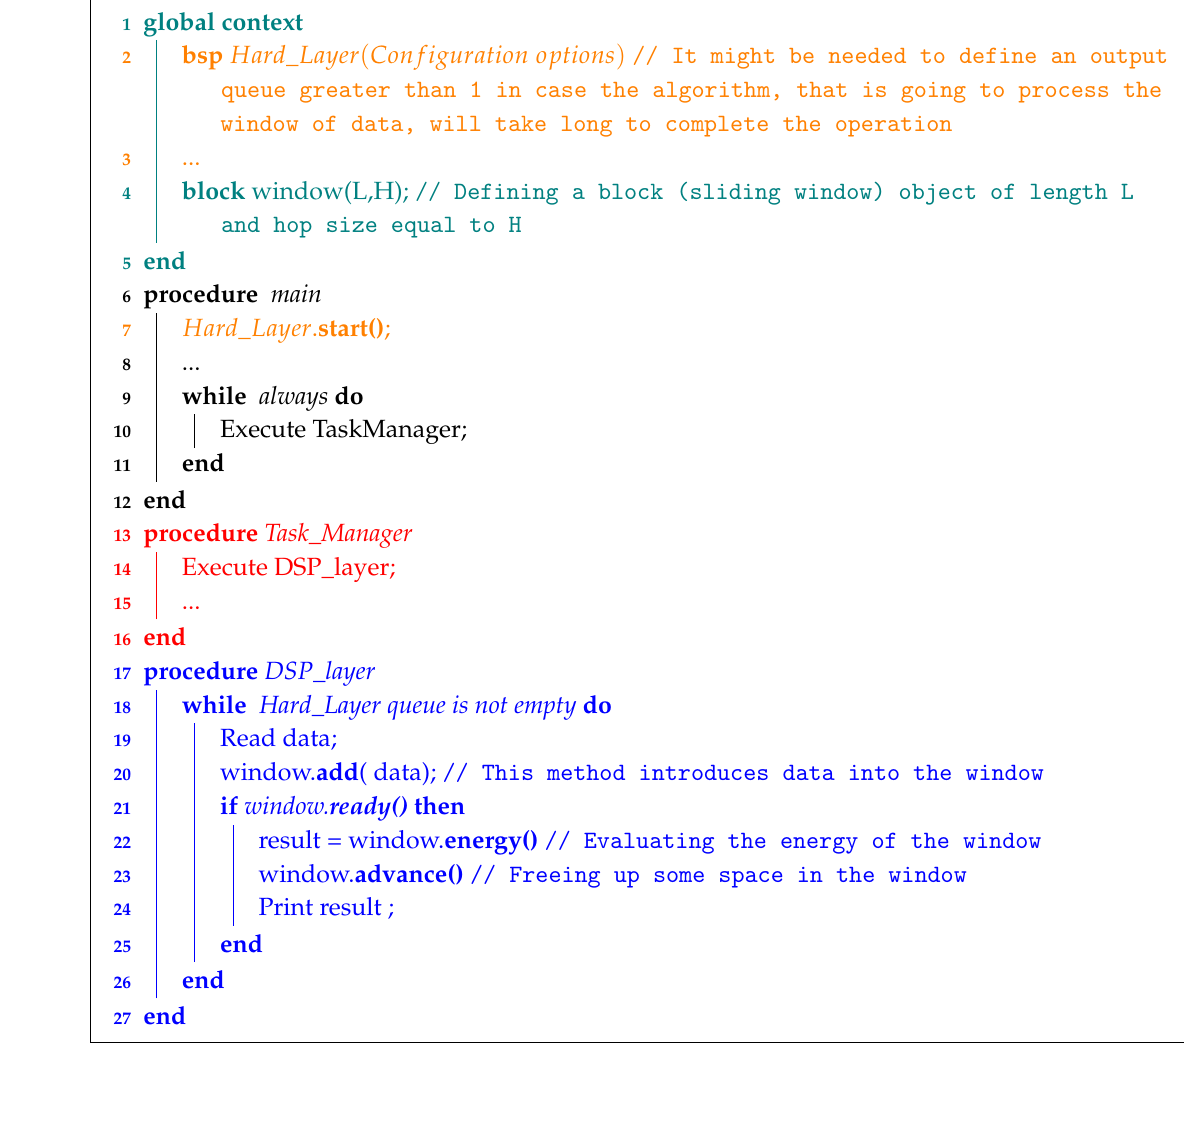
Algorithm 6: Programming example illustrating how to use the block